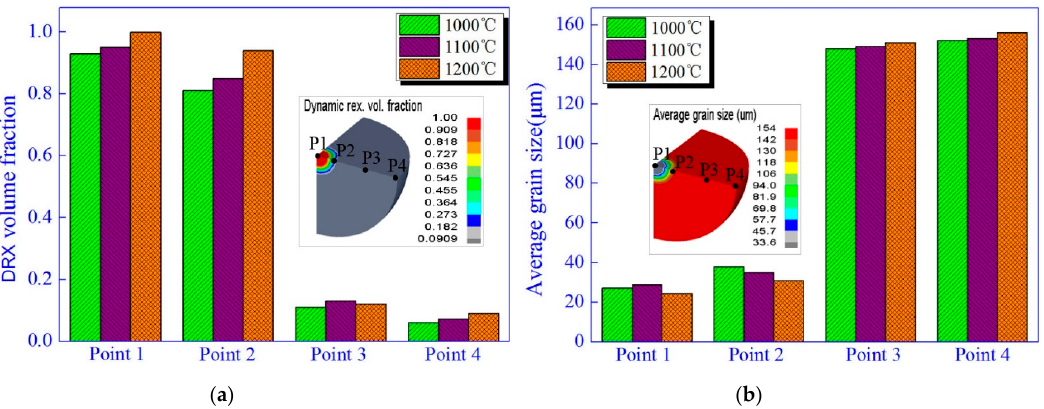
Figure 10. Effect of temperature on grain size and DRX in the steel ball at the final stage of FPM. ( a ) Effect of temperature on DRX; ( b ) Effect of temperature on grain size.